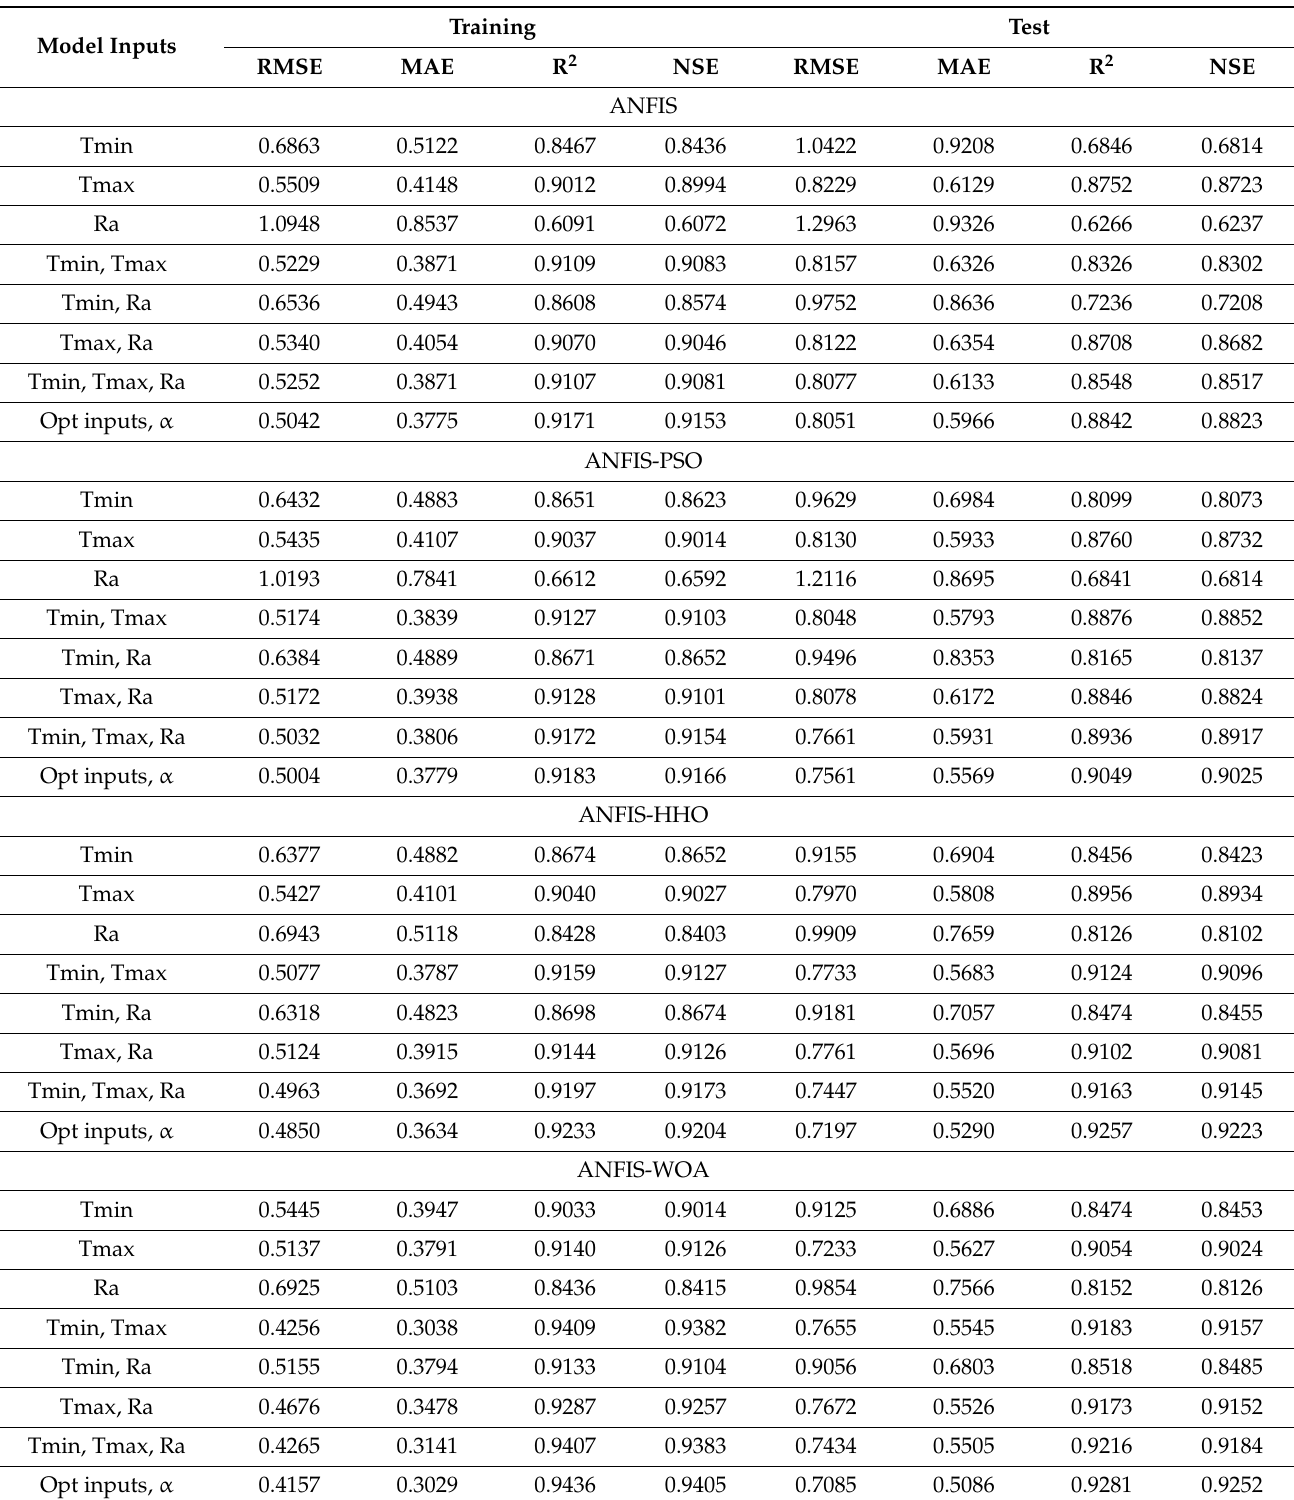
Table 7. Training and testing performances of the models for monthly Epan prediction—Nanxian Station using data from Jingzhou